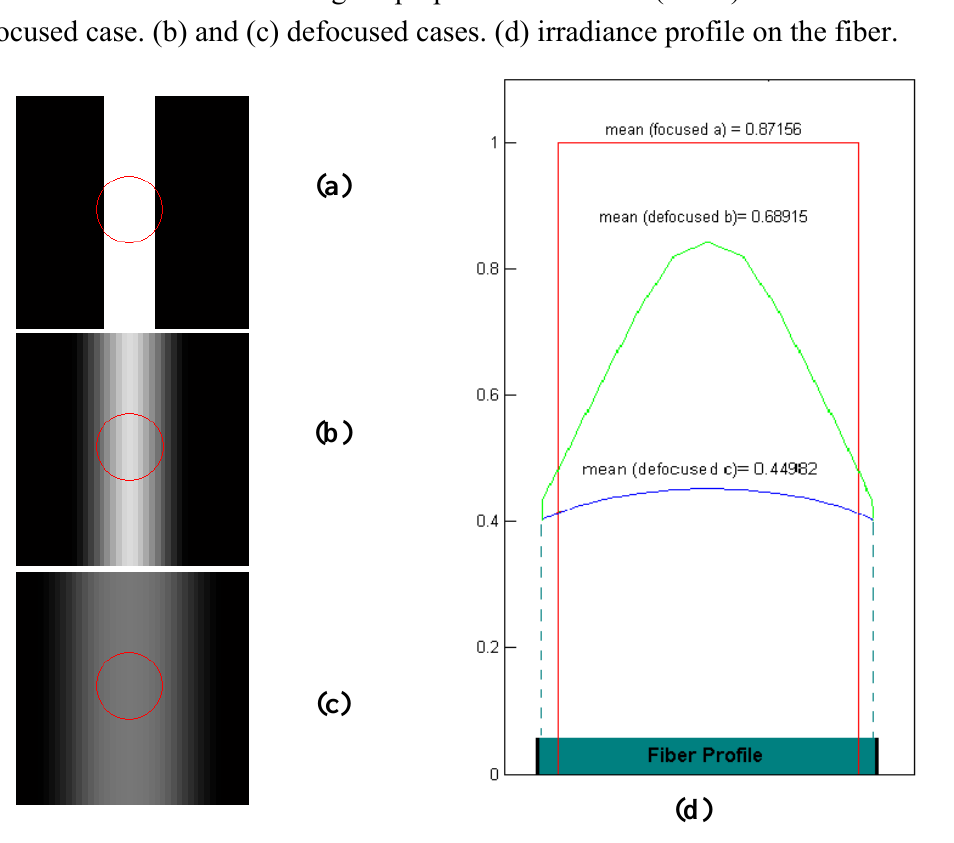
Figure 4. Simulation of the fringe superposition on fibers (circle) when focus is